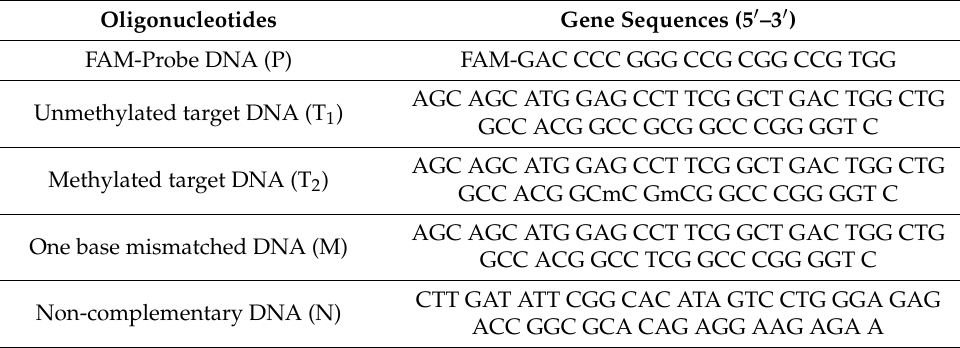
Table 1. Used DNA sequences. Oligonucleotides Gene Sequences (5 (cid:48) –3 (cid:48)